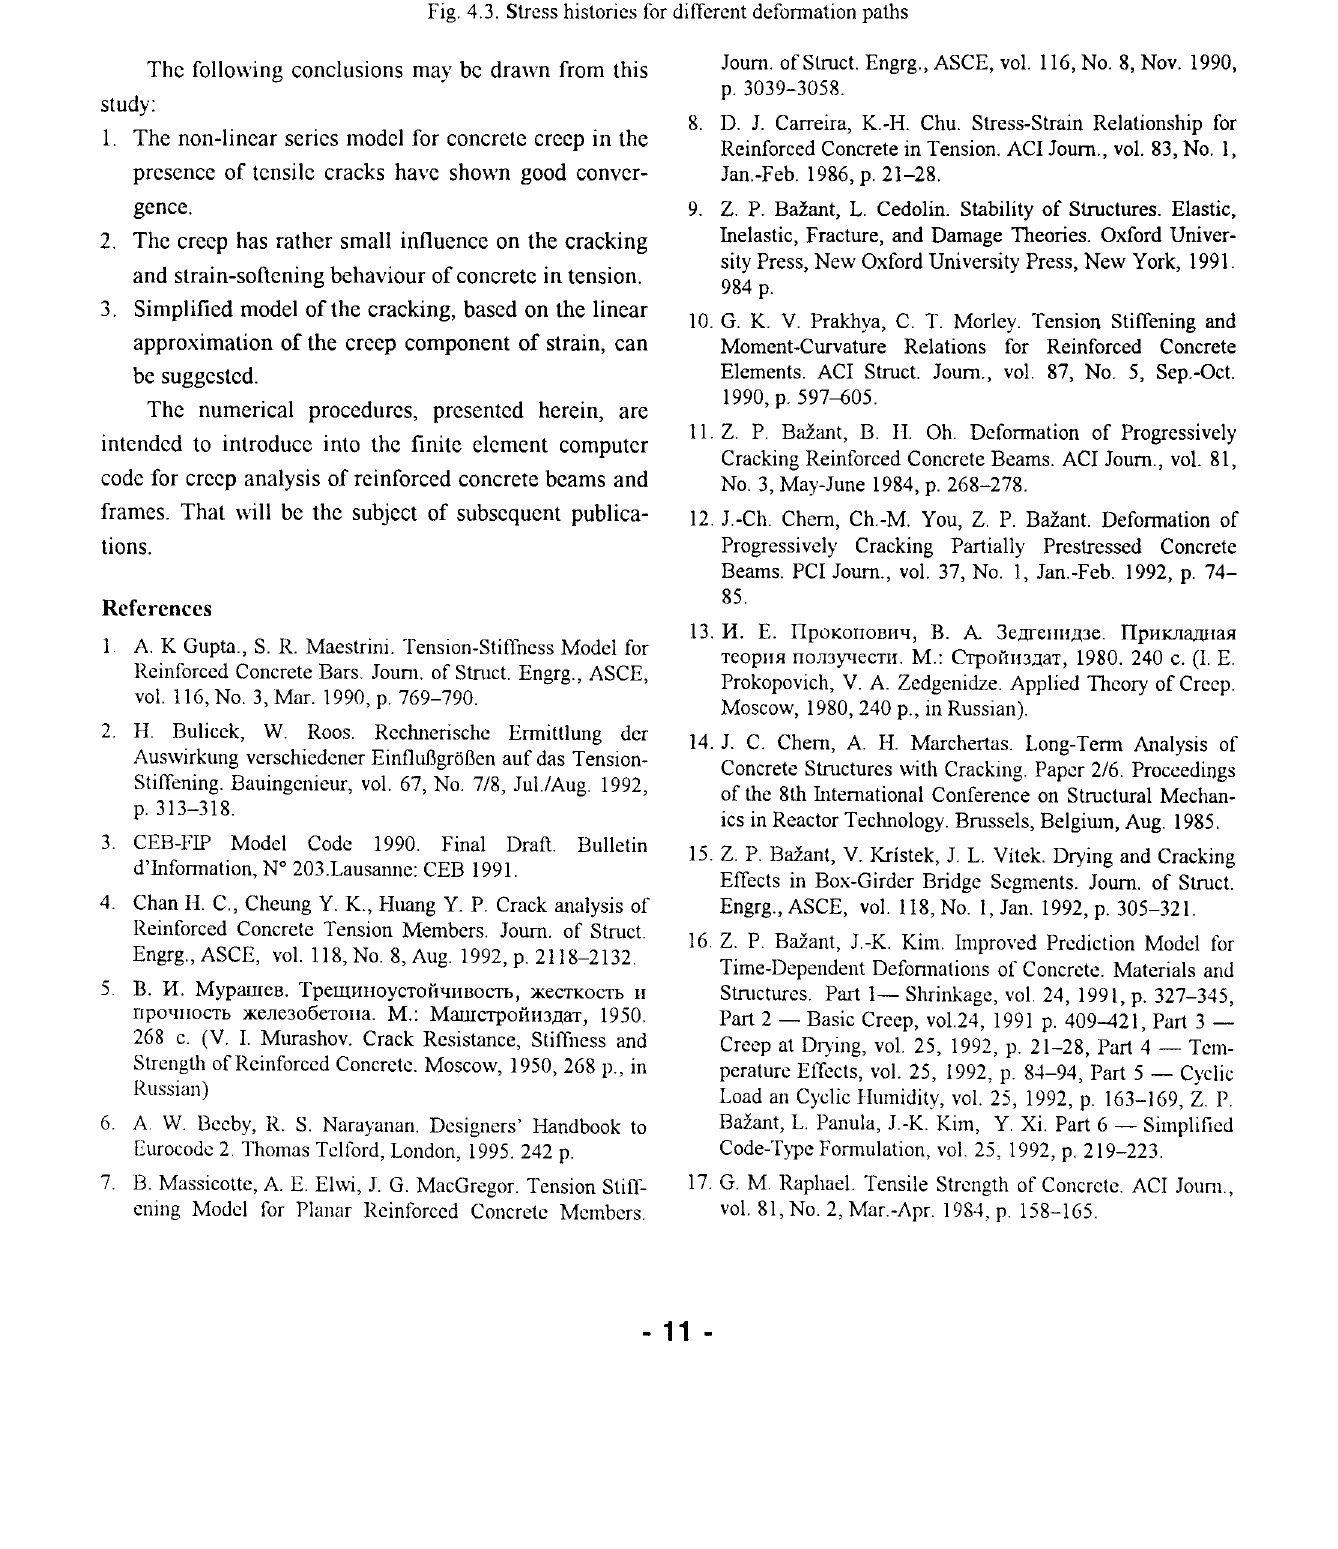
Fig. 4.3. Stress histories for different deformation